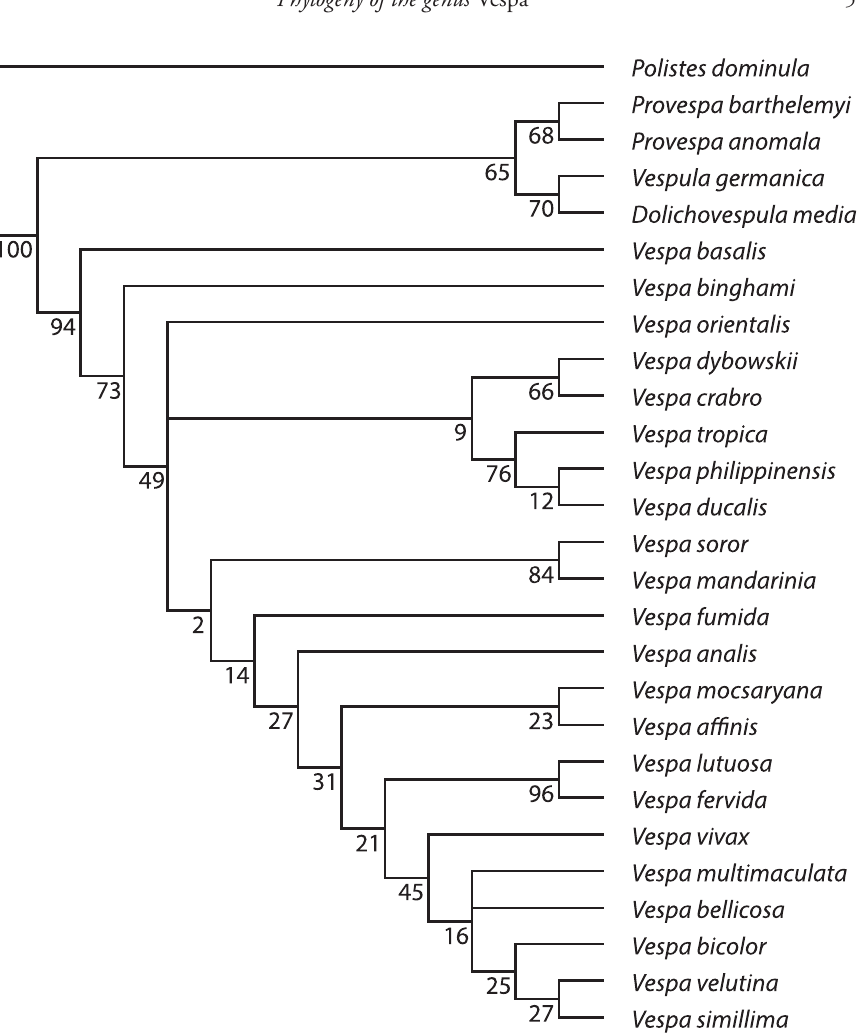
Figure 2. Support tree for relationships among the 22 Vespa species based on 45 morphological charac- ters. Supports for nodes are given in GC-values (see text for explanation) when they are greater than